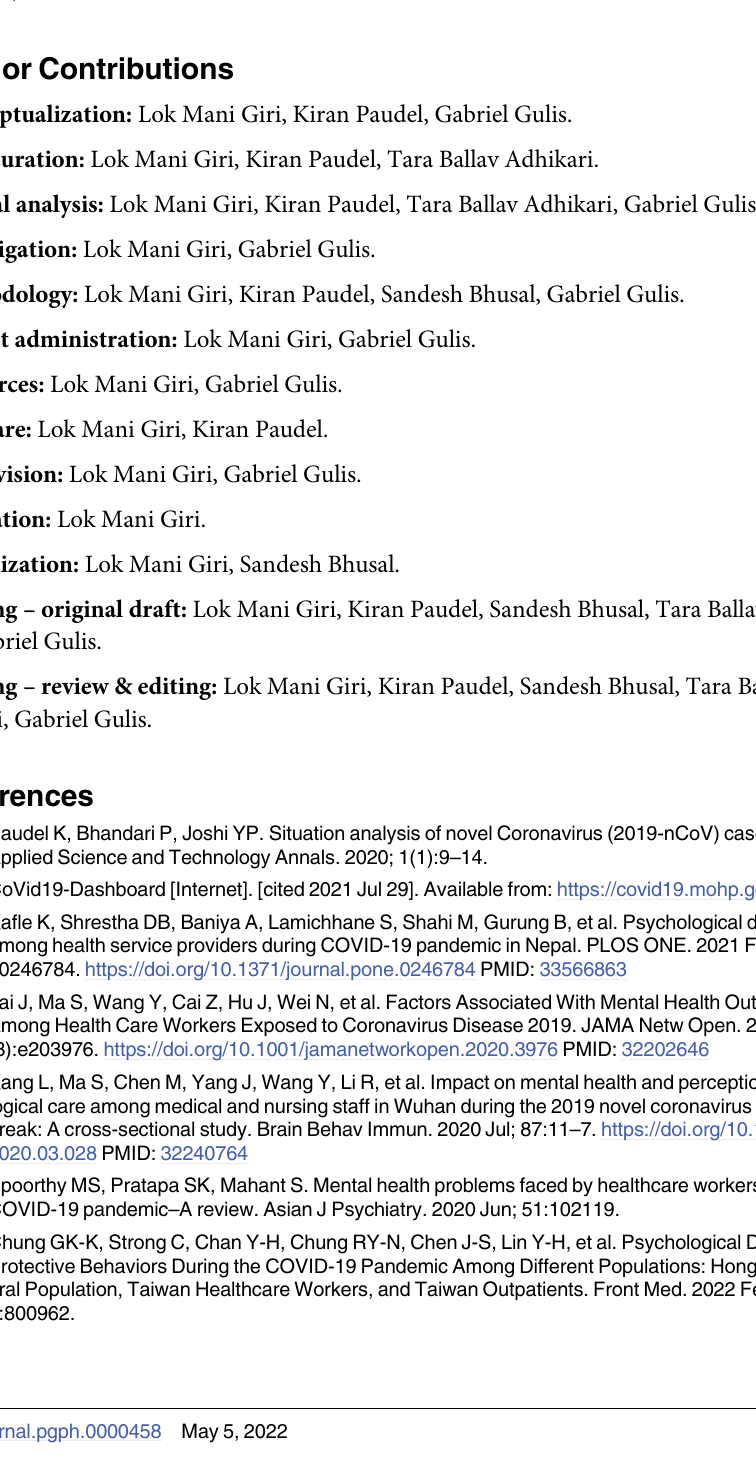
S1 Table. Association between stress with independent variables. S2 Table. Sociodemographic factors associated with perceived stigma. S3 Table. Association between sociodemographic factors and social